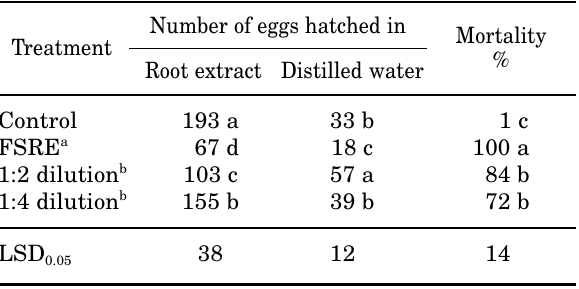
Table 1. Effect of root extracts of Lantana camara at various concentrations on mortality of Meloidogyne java- nica juveniles after 24